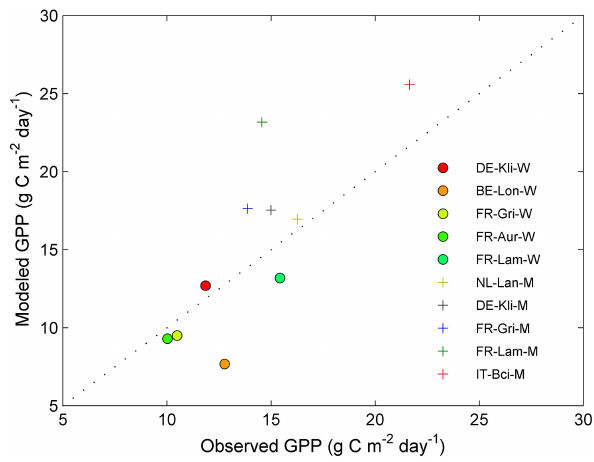
Figure 10. Comparisons between the observed and modeled (based on ORC-CP5) mean growing-season GPP among different crop sites for winter wheat (circle, -W) and maize (cross, -M). Differ- ent colors indicate different